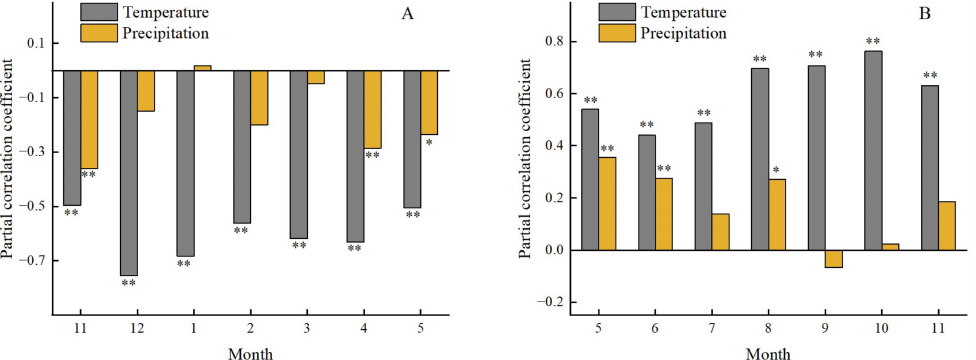
Figure 22. Partial correlation coefficient between forest phenological parameters and temperature and precipitation. ( A ) is SOS; ( B ) is EOS. Note: * p < 0.05, ** p < 0.01.